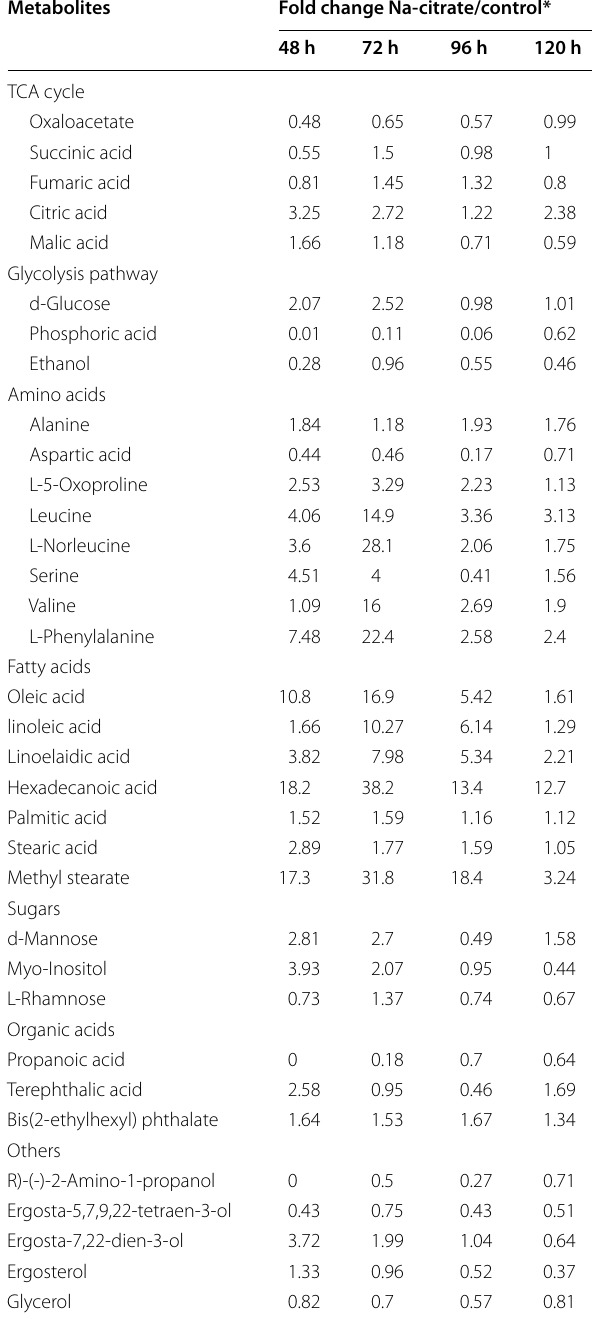
Table 3 Relative changes in the cell metabolite abundance when cultured with Na-citrate versus control